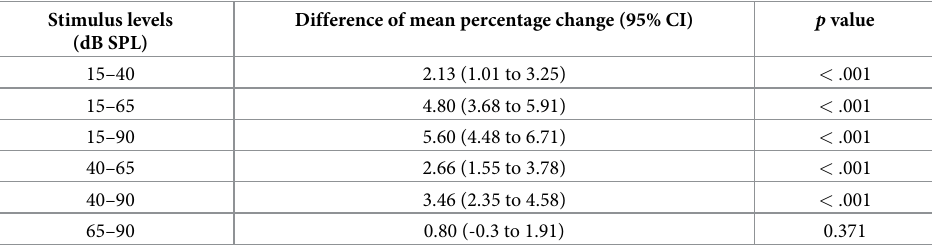
Table 2. Comparison between mean percentage change from baseline (95% confidence interval of difference) at different stimulus levels, across inter-beat intervals three to